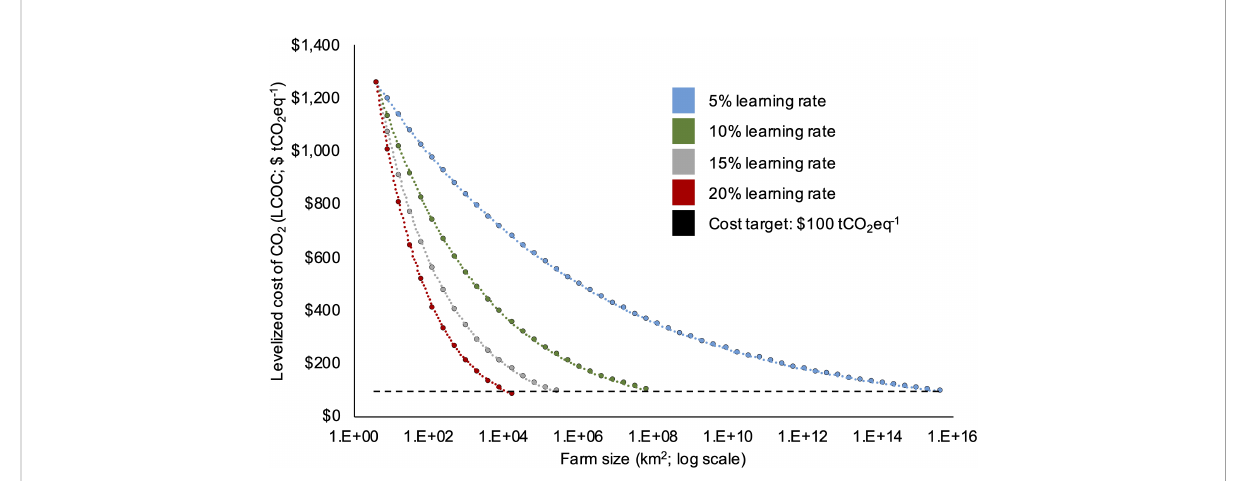
FIGURE 9 Levelized cost of CO 2 (LCOC; $ tCO 2 eq -1 ) as a function of farm size (km 2 ) under four learning rate (LR) scenarios: 5%, 10%, 15%, and 20% reductions in cost with each doubling of scale. The horizontal dashed line denotes a hypothetical cost target of $100 tCO 2 eq -1 . The “ optimized ” bio-techno-economic model ($1,257 tCO 2 eq -1 ) was used as the starting point in this